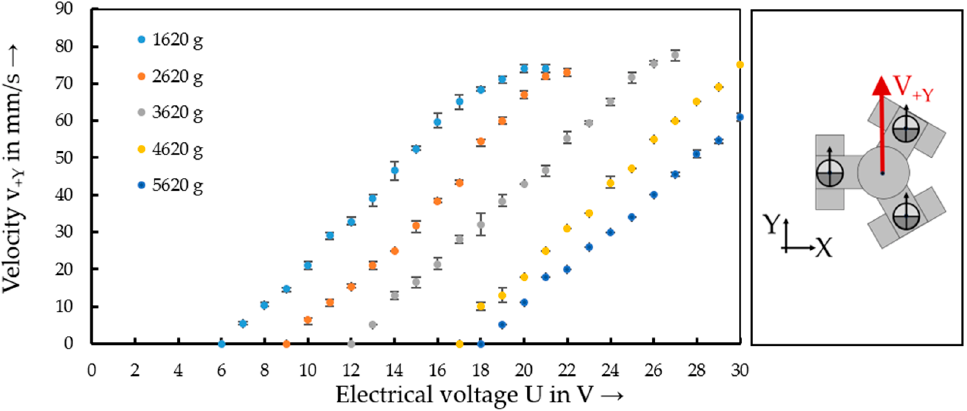
Figure 9. Measurement results of the maximum drive velocity ˆ v − X of the planar motor platform in the − X direction for different transport load scenarios. Table 2. Appropriate operating ranges for velocity in the − X direction.